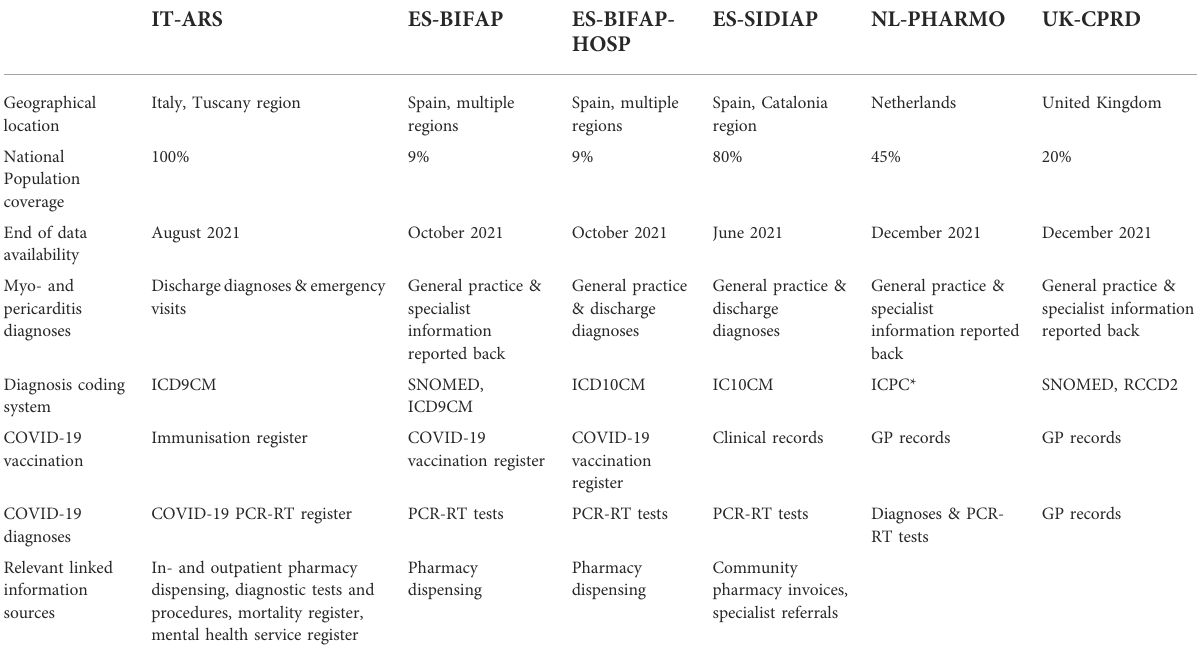
TABLE 1 Characteristics of the participating data